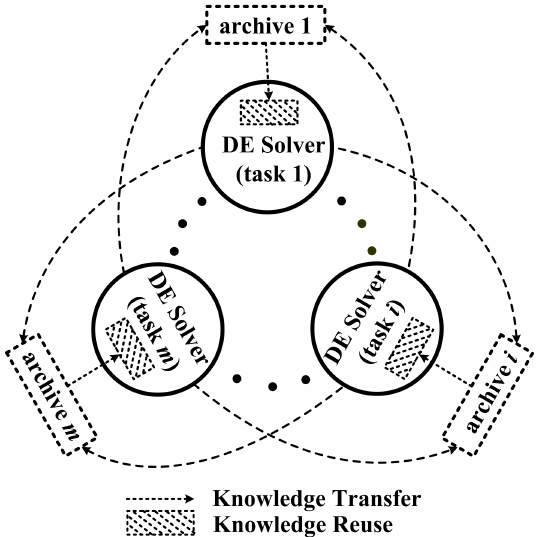
Figure 10. An illustration of multitasking DE (MTDE) framework